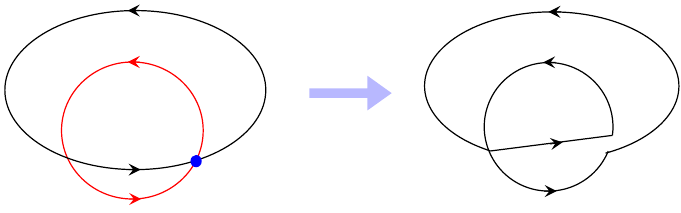
Figure 12 . The action of the loop equation on the two intersection loop. After using the loop equation to the point colored in blue, we obtain a one-intersection loop with areas A 1 and A 2 (cid:0) A 3